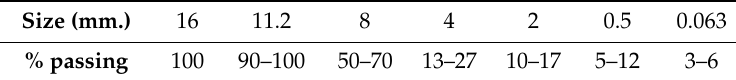
Table 3. Particle size envelope of the PA-11 porous asphalt